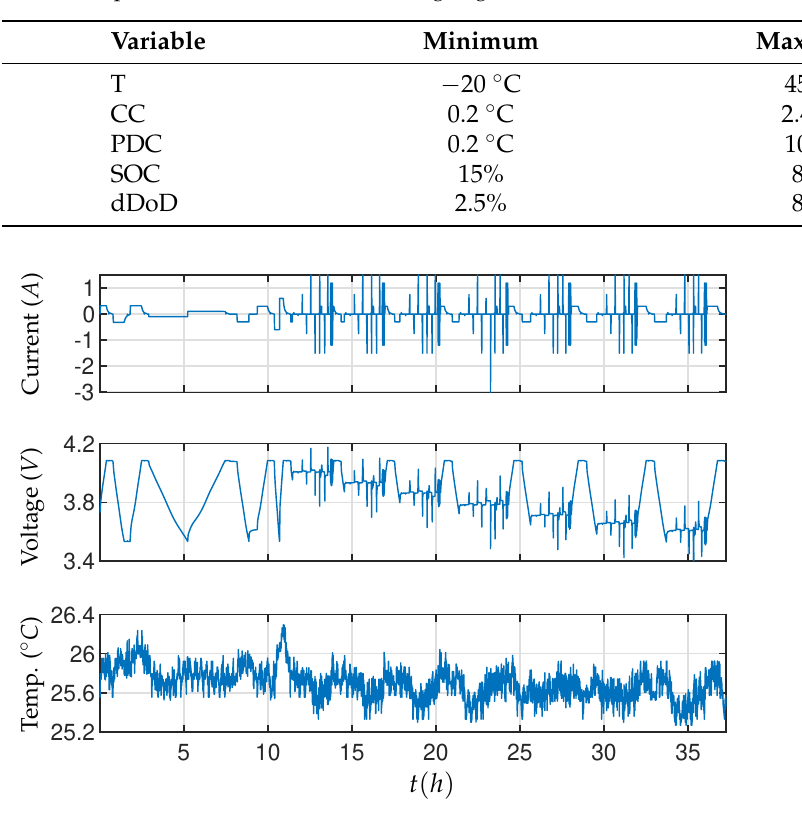
Figure 2. Current, voltage and temperature profiles over time from a reference test cycle showing characterization pulses at varying SoCs.